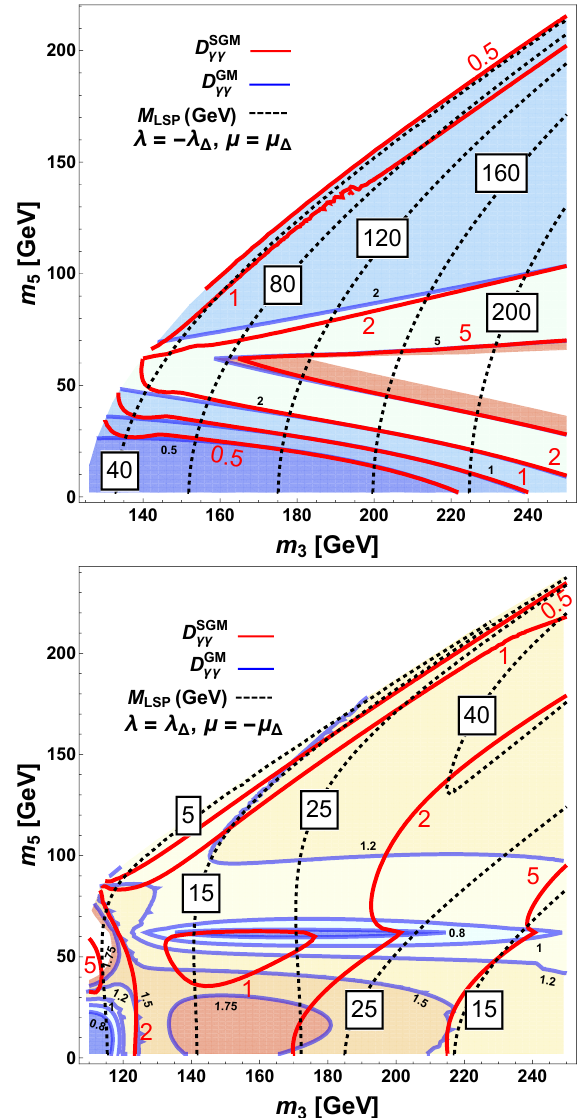
Figure 3 . Top : contours of the ‘Higgs golden ratio’ D SM for the SM-like Higgs as de(cid:12)ned in eq. (3.5) (cid:13)(cid:13) for the GM model (blue solid lines with background color) and SGM model (red solid line) with contours of the LSP mass (black dashed lines) and inputs de(cid:12)ned for Point 1 in eq. (3.4). Bottom : same as top, but for Point 2 in eq.